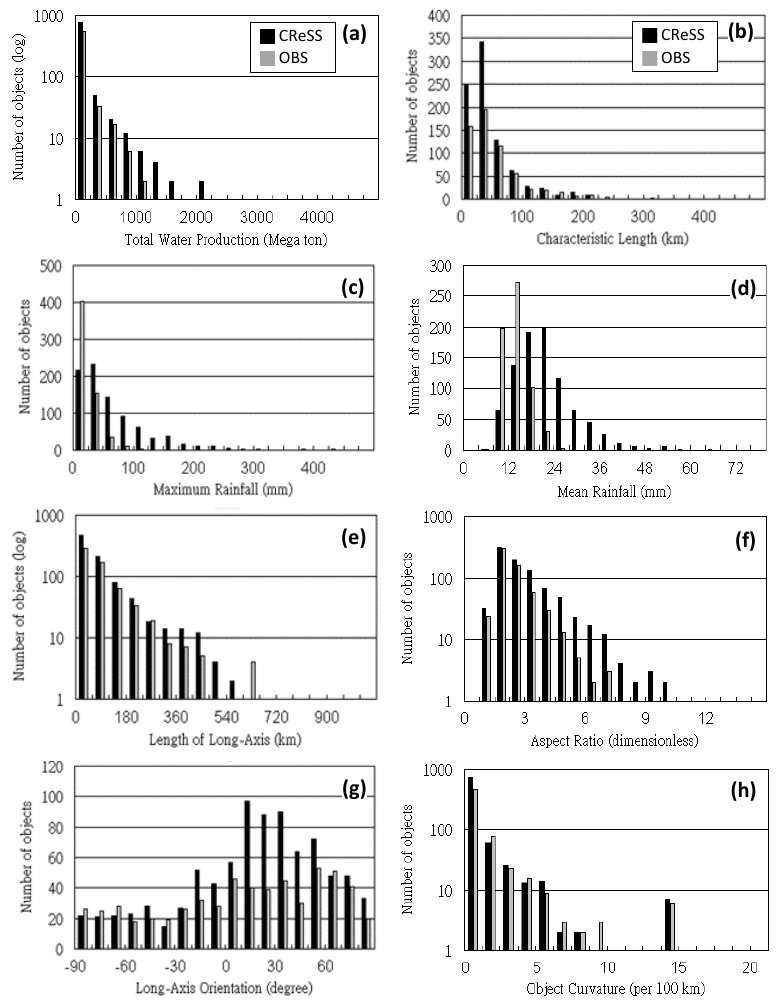
Figure 6. As in Figure 4, but for the matched object pairs at successive times (every 3 h), i.e., the MRSs, in the observation and in CReSS QPFs at the range of 12–36 h, initialized daily at 00:00 UTC. ( a ) Total water production (mega ton), ( b ) characteristic length (km), ( c ) maximum rainfall (mm), ( d ) areal-mean rainfall (mm), ( e ) long-axis length (km), ( f ) aspect ratio (dimensionless), ( g ) long-axis orientation (degree), and ( h ) object curvature (10 − 2 , or radius per 100 km). The total number of 607 MRSs and 868 MRSs are identified in the observation and model forecasts, respectively. In panels ( a , ( e ), ( f ), and ( h ), the logarithmic scale is used in the vertical